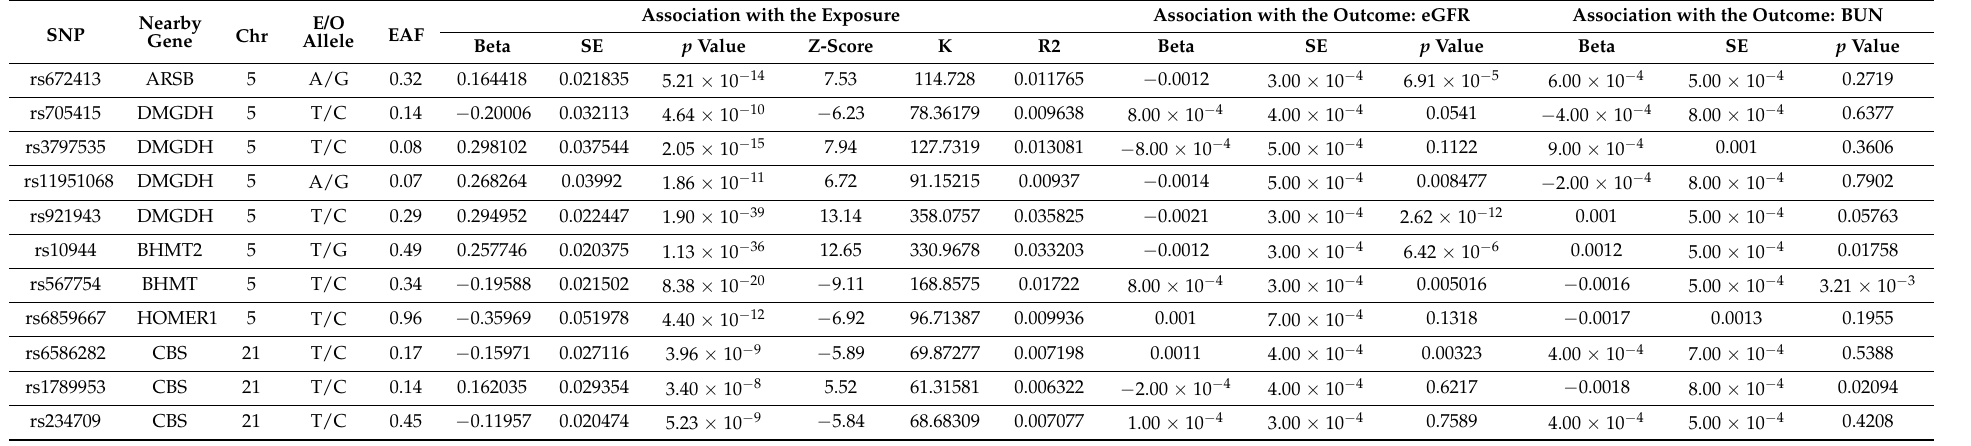
Table 1. The instrumental variables used to genetically predict the selenium